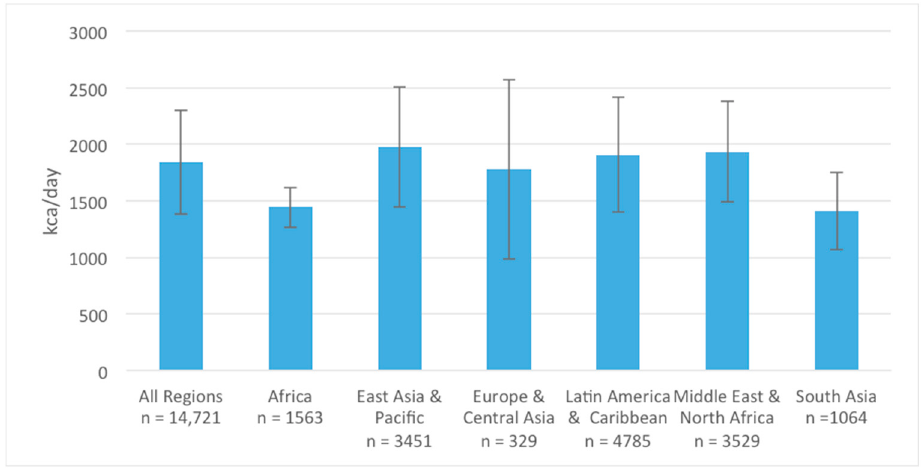
Figure 3. Adolescent girls’ energy intake (kcal/day) across different geographical world regions.